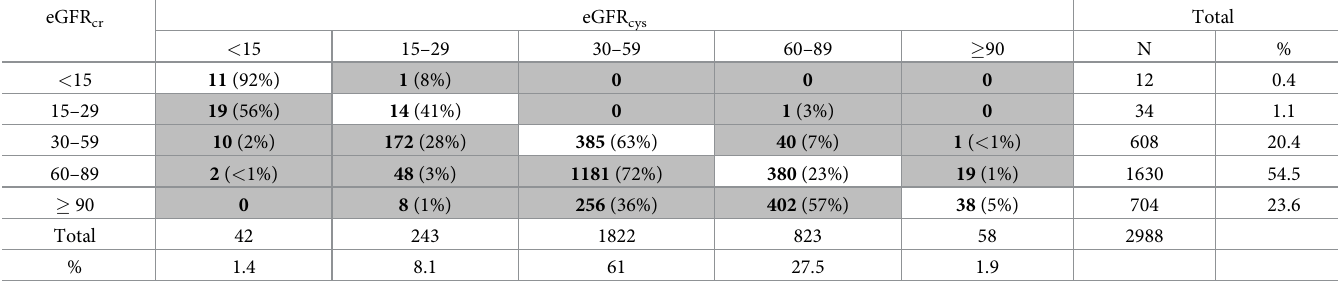
Table 3. Distribution of CKD stage by GFR-estimating equation.